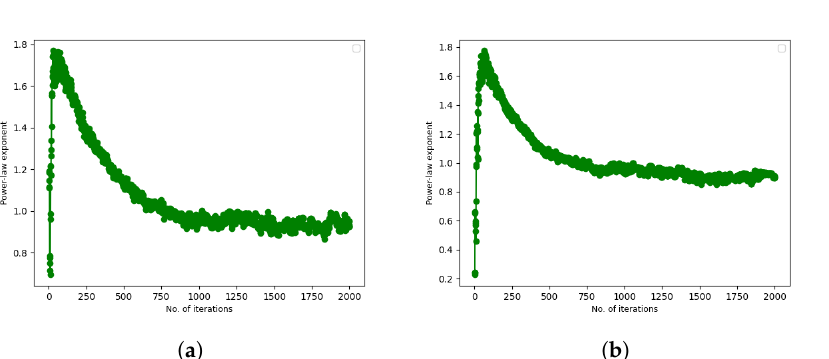
Figure 4. Power-law exponent against the number of iterations of rewiring. The figures indicate that the power-law exponent reaches 1, indicative of a core-periphery topology emerging, over 2000 itera- tions of preferential rewiring based on node rationality. This happens whether the node rationality is ( a ) positively or ( b ) negatively correlated with the